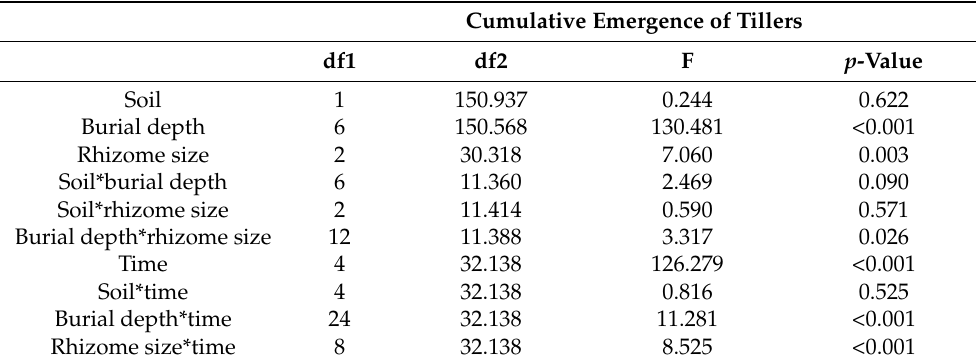
Table 1. Summary of ANOVA for all main effects and their interaction from the mixed models for the cumulative emergence of